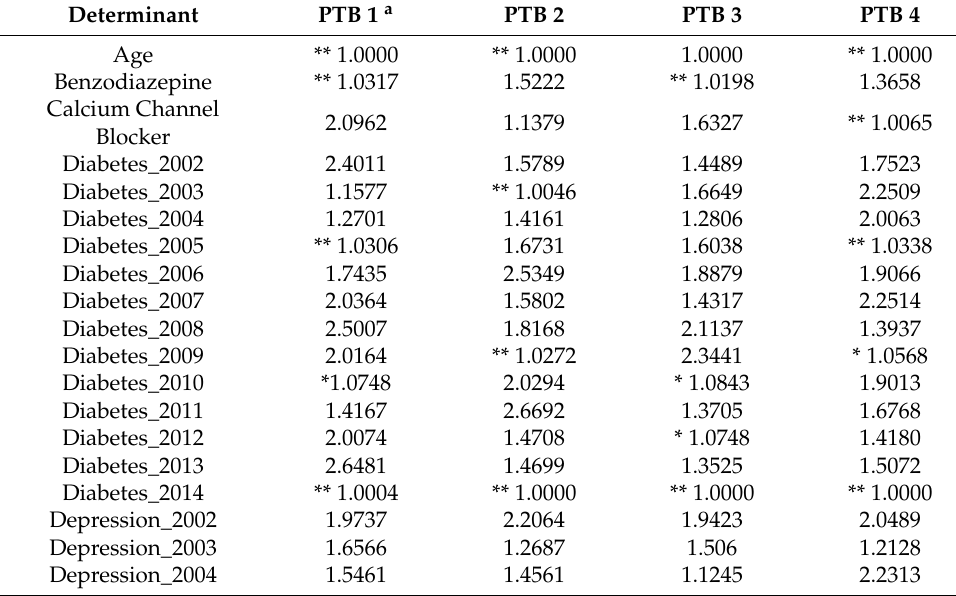
Table 5. Coefficients of determinants from logistic regression with